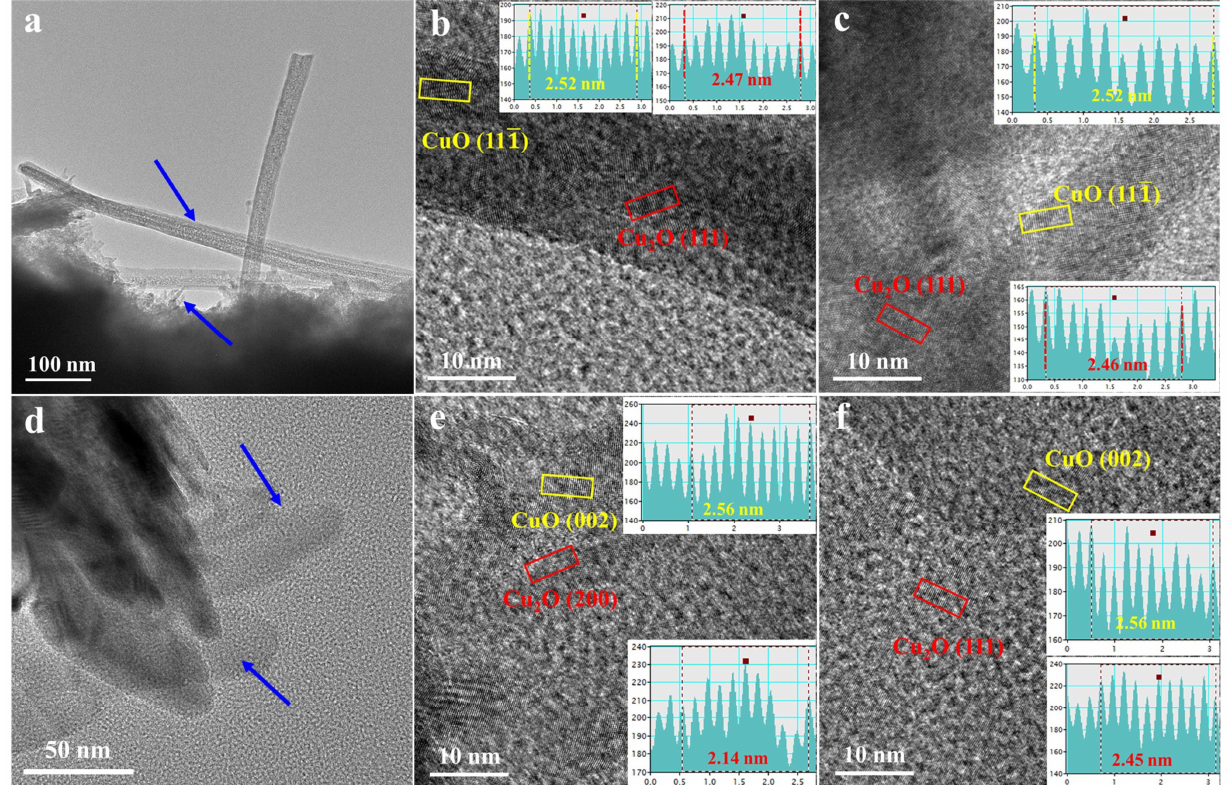
Figure 4. ( a ) TEM image of O-Cu-15m, ( b ) HRTEM image of a nanobelt area, ( c ) HRTEM image of a nanoflake area; ( d ) TEM image of O-Cu-2h, ( e , f ) HRTEM image of two typical nanoflake